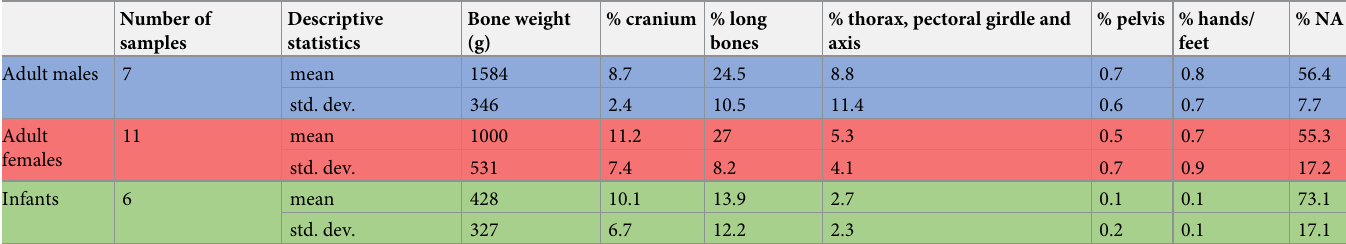
Table 3. Relative weight (in %) of the anatomical districts for each category of individuals. Two adults of undetermined sex (n. 208, 433) are not included. Number of samples